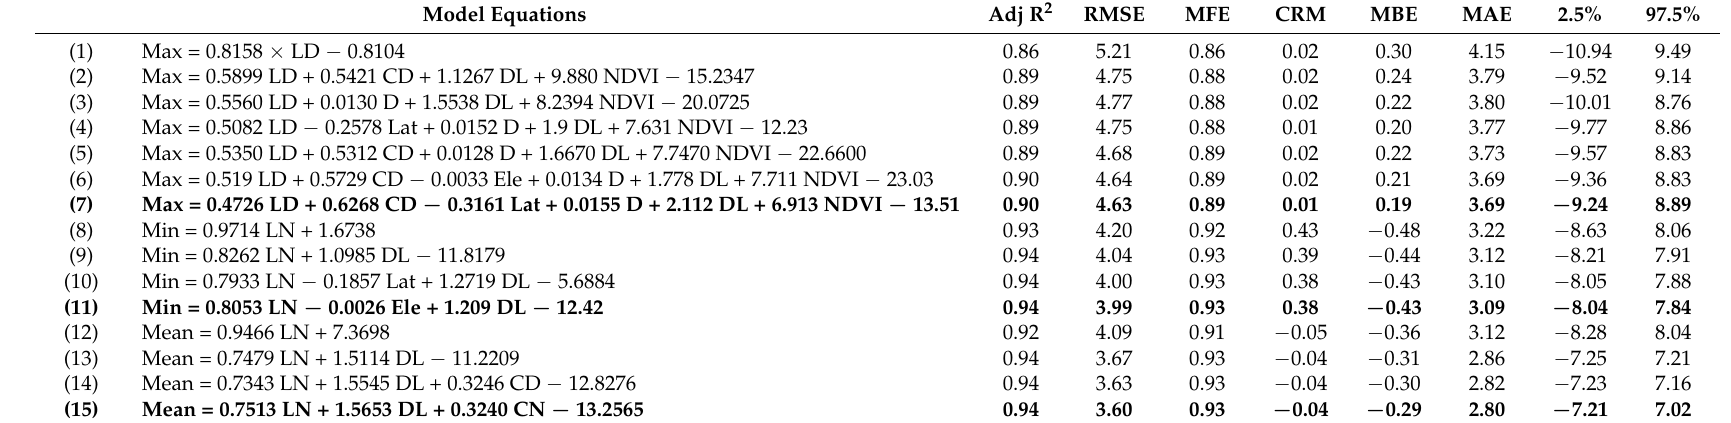
Table 2. Model equations and validation accuracy for T max , model accuracy is given by Adj R 2 , RMSE, MAE, MFE and R 2 change. Model